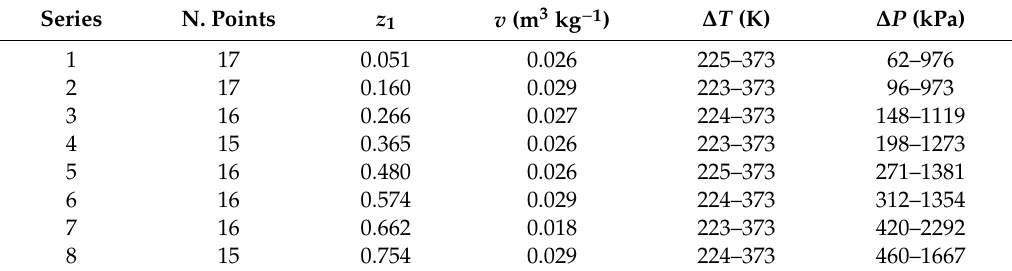
Table 2. Measurements at bulk compositions z 1 and average specific volumes v for R744 (1) + R1234yf (2) binary system over the temperature range ∆ T and pressure range ∆ P .